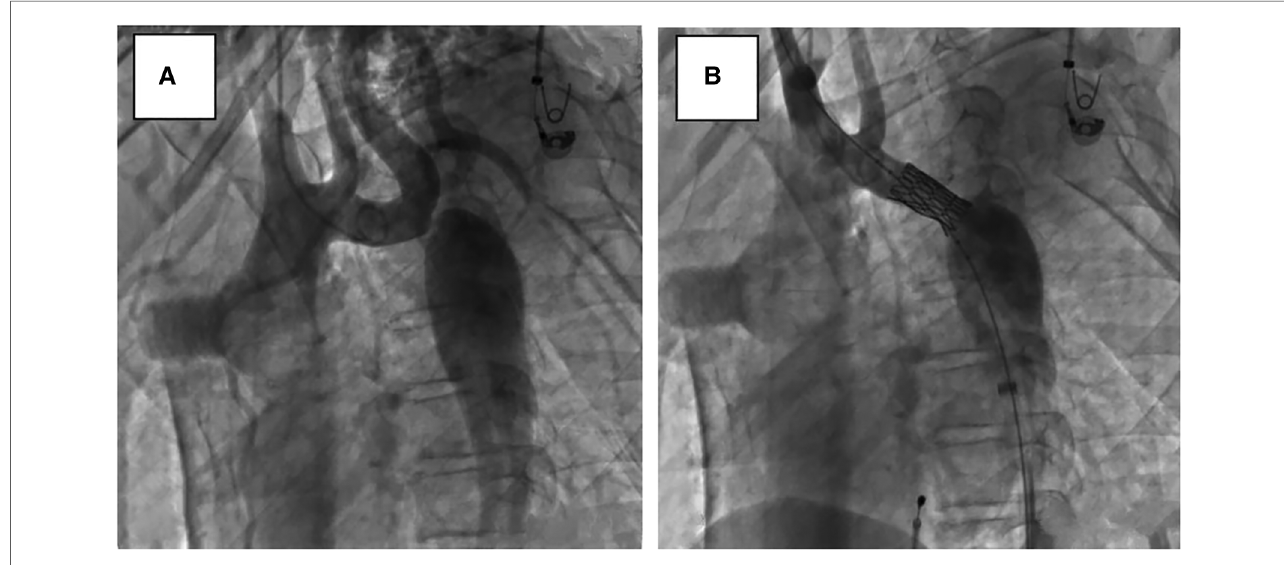
FIGURE 3 Lateral view, descending aortograms: ( A ) prior to stenting, ( B ) immediately after stenting.